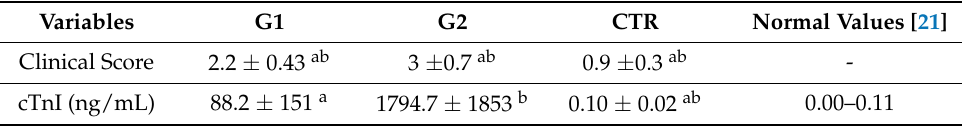
Table 5. Comparison of SIRS scoring and cTnI value between dogs with a favorable prognosis (G1), poor prognosis (G2) and control